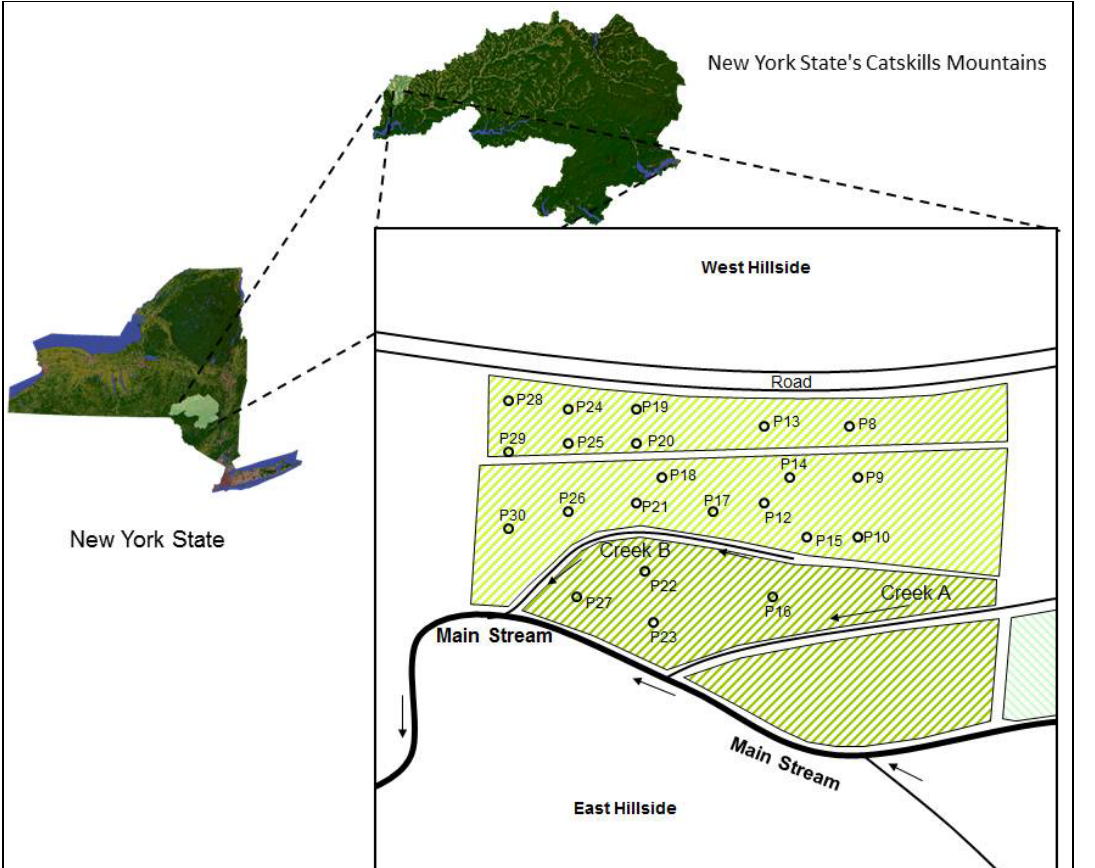
Figure 1. Location of the study area within the Catskills mountains, and the location of the